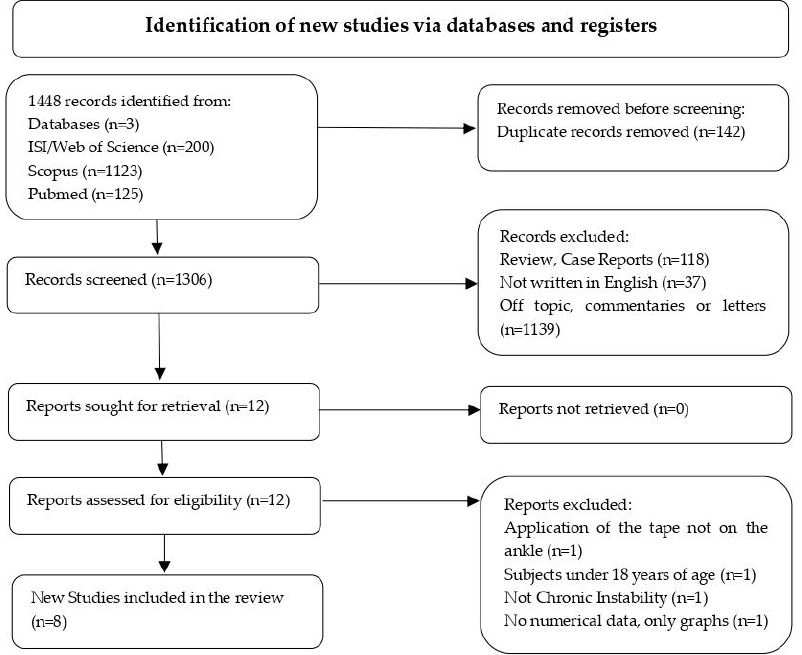
Figure 1. Systematic Reviews and Meta-Analyses (PRISMA) flow chart showing the process for inclusion of papers. For this study, 14 articles were assessed for eligibility after screening: among these, 8 new studies were included in the analysis [41]. Table 1. Study Characteristics.